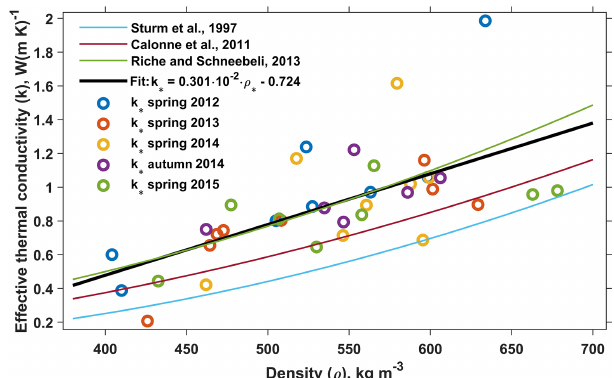
Figure 8. Relation between effective thermal conductivities k and densities ρ . Markers illustrate the results of the optimization rou- tine; the black line shows the linear fit based on all k ∗ – ρ ∗ pairs. The light blue, ruby and green curves show quadratic k = f (ρ) func- tions according to Sturm et al. (1997), Calonne et al. (2011), and Riche and Schneebeli